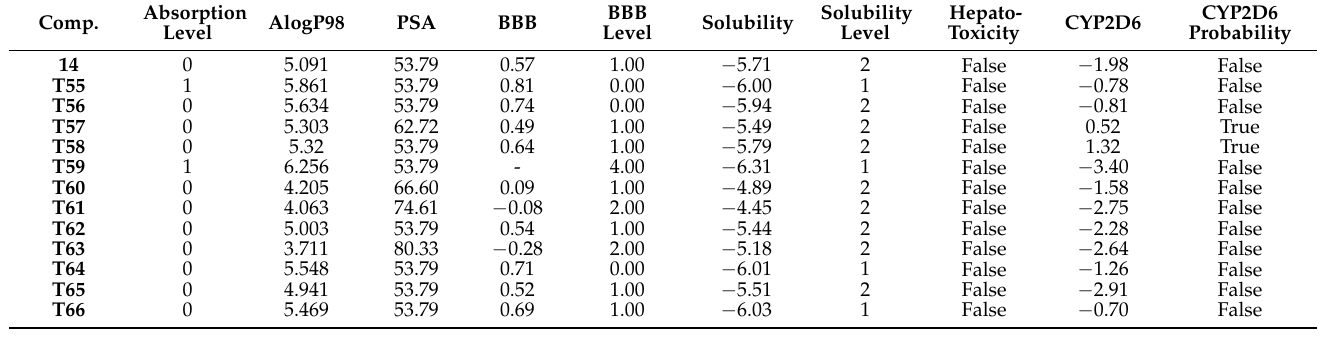
Table 6. In silico ADMET prediction of newly designed compounds and the most potent template molecule.